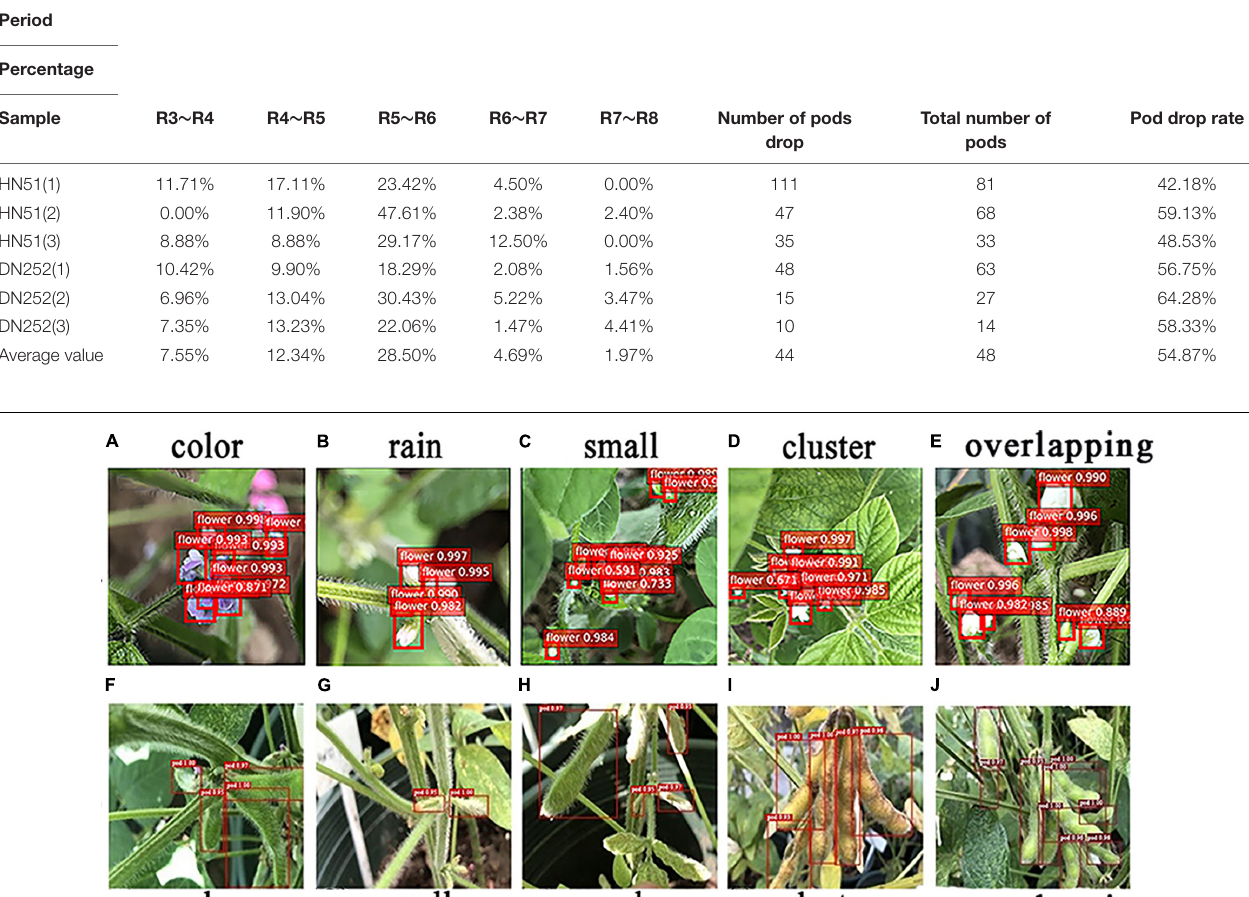
TABLE 7 | The pod drop rate at different reproductive stages.